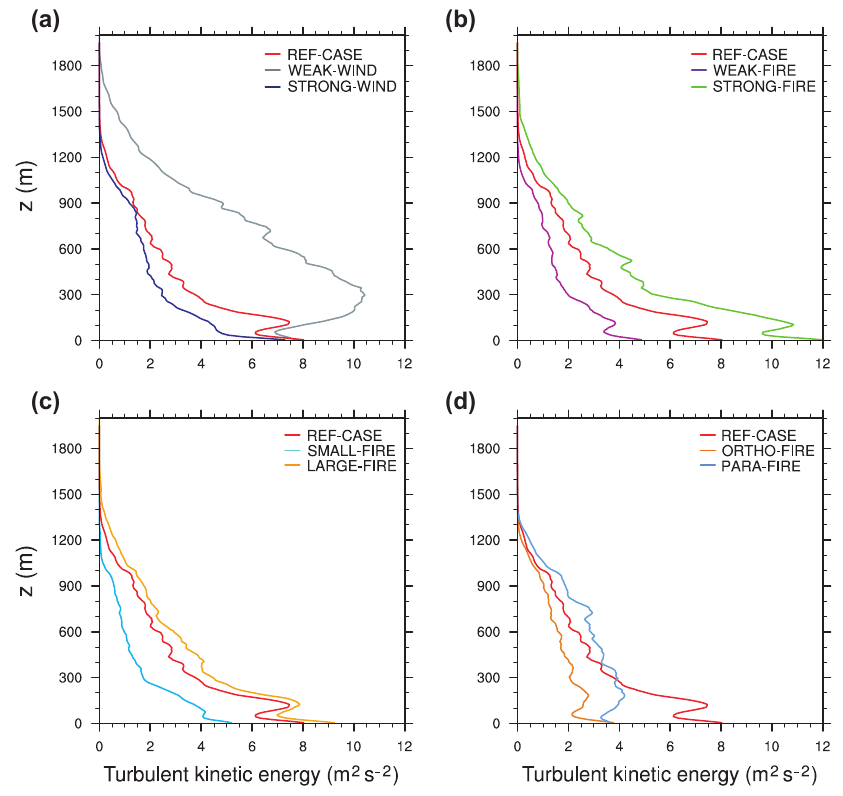
Figure 7. Vertical profiles of the turbulent kinetic energy (TKE) for the different case simulations. Compared are the impacts of (a) different ambient wind velocities, (b) fire intensities, (c) fire sizes, and (d) fire shapes and orientations. Plotted are means of the maximum values per time